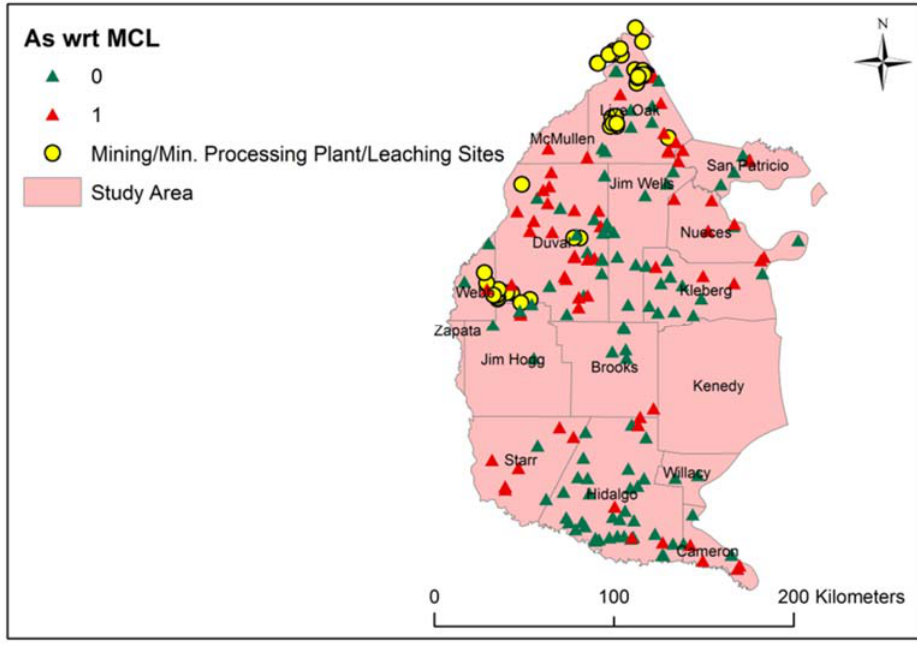
Figure 2. Spatial distribution of arsenic and uranium plants in the study area.